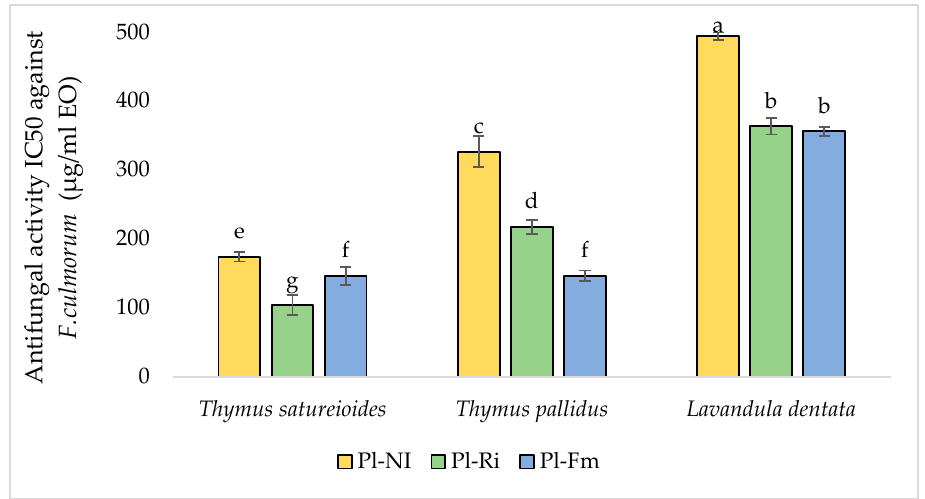
Figure 11. Antifungal activity IC 50 of essential oil of Thymus satureioides (Ts), Thymus pallidus (Tp), and Lavandula dentata (Ld), inoculated with Rhizophagus irregularis (Ri) or Funneliformis mosseae (Fm) after 4 months of culture under greenhouse conditions. Bars followed by the same letter are not significantly different according to Tukey’s HSD test ( p < 0.05) .